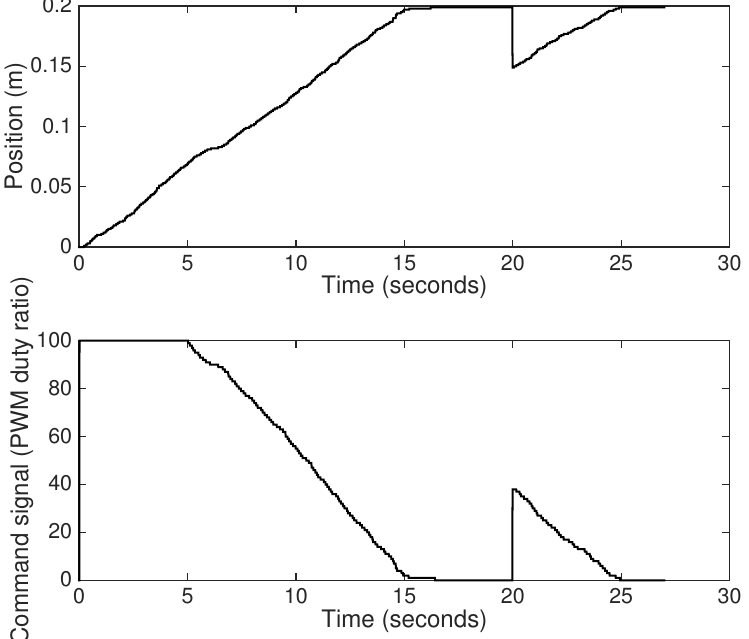
Figure 9. Fractional order PD controller experimental validation in a Newtonian